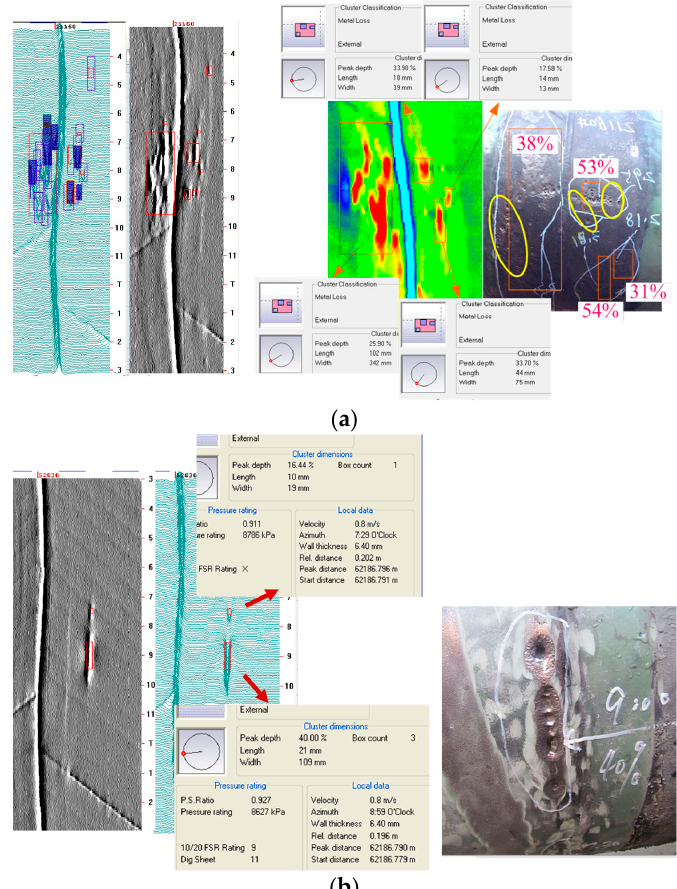
Figure 11. Typical signals and excavation pictures for type 1. ( a ) Excavation results of defect with peak depth of 33.9% WT; ( b ) Excavation results of defect with peak depth of 40.4% WT. Type 2: Circumferential length of defect (signal or combined) is above 40 mm with depth above 5% WT. Typical picture is shown in Figure 12.